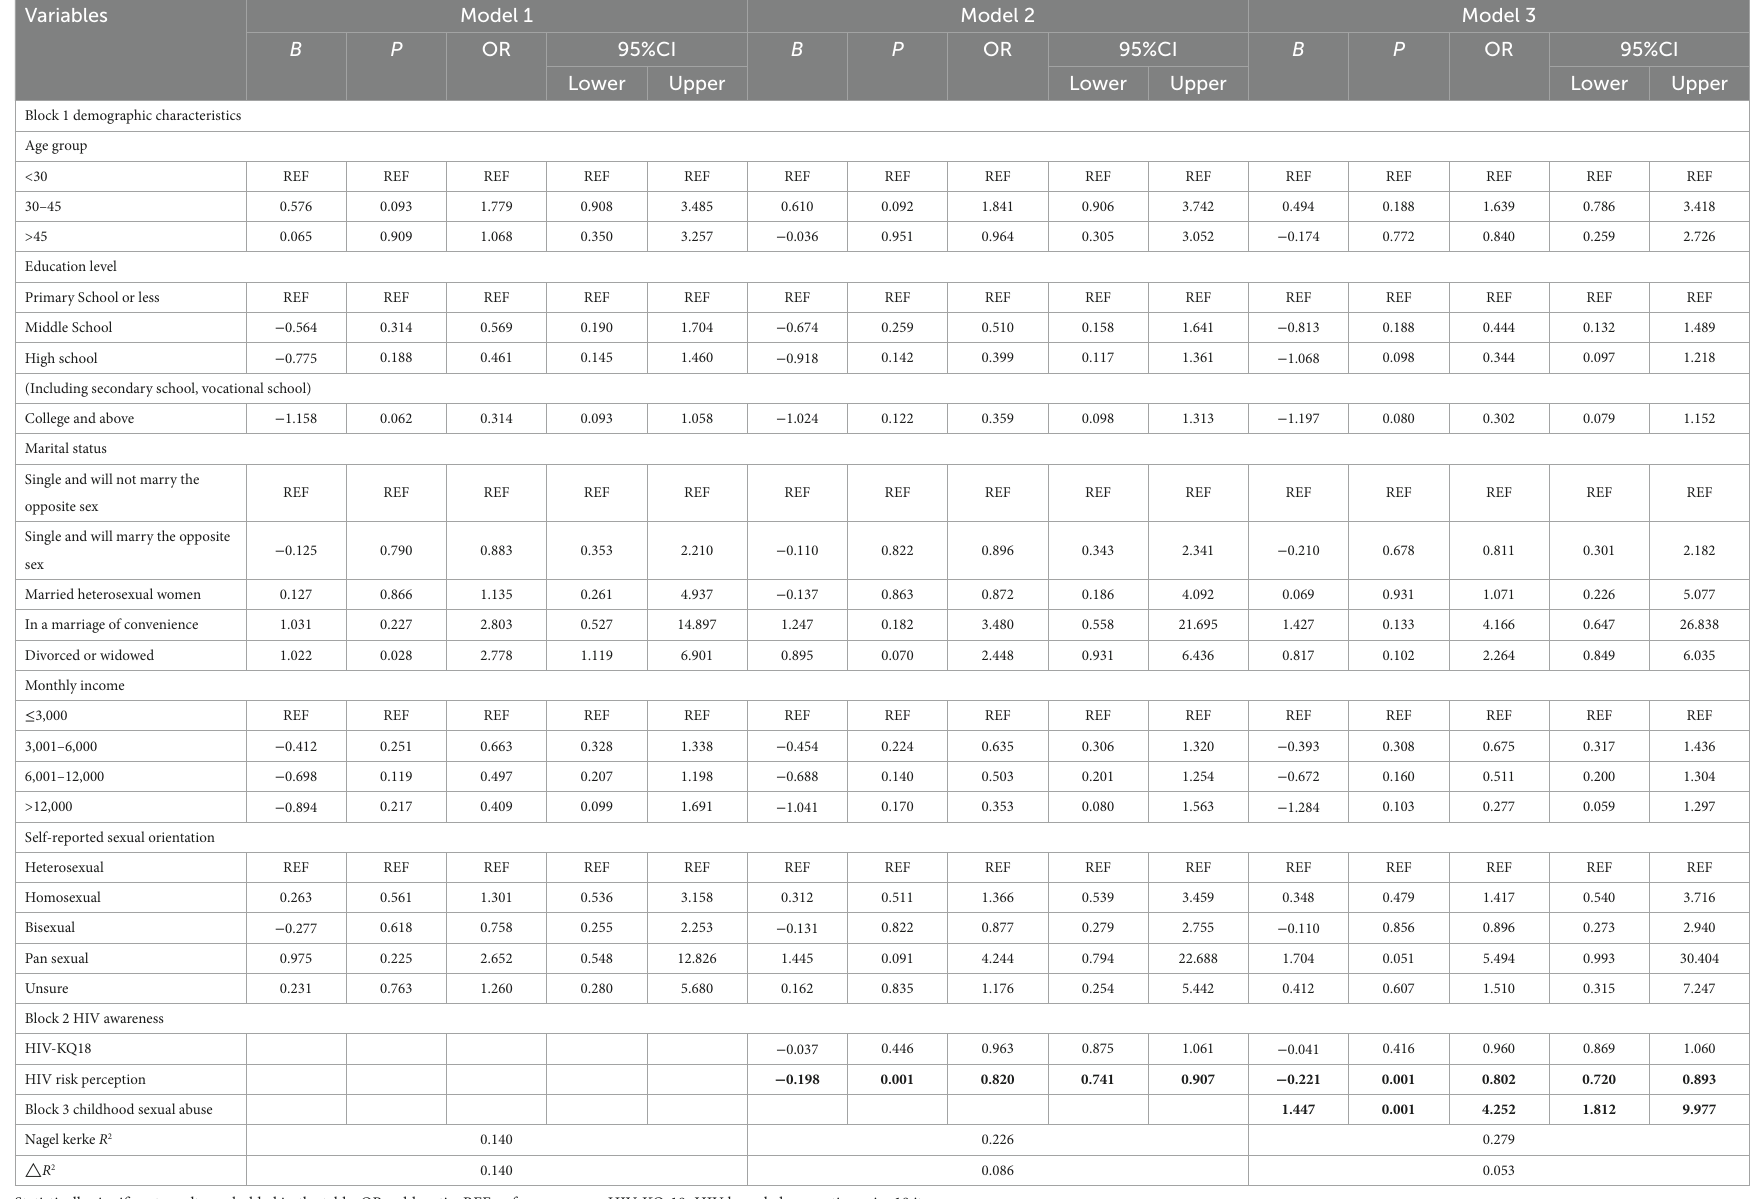
TABLE 2 Hierarchical logistic regression models of condomless anal